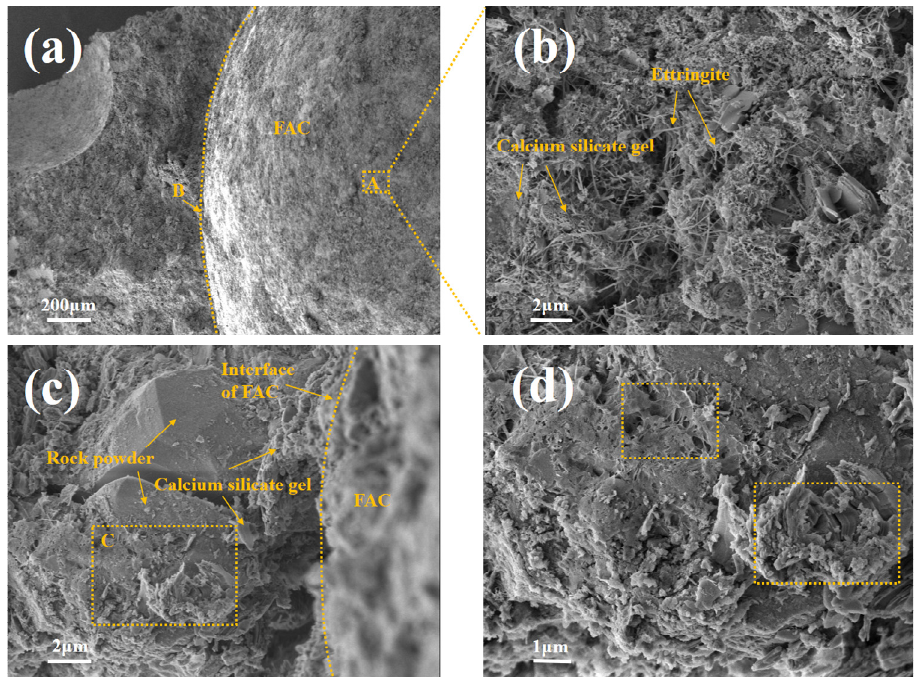
Figure 13. SEM micrographs of the ( a ) FAC particles inside the NCRPB, ( b ) FAC particle surface, ( c ) FAC particle boundary and ( d ) magnified SEM image of the box region in ( c ).